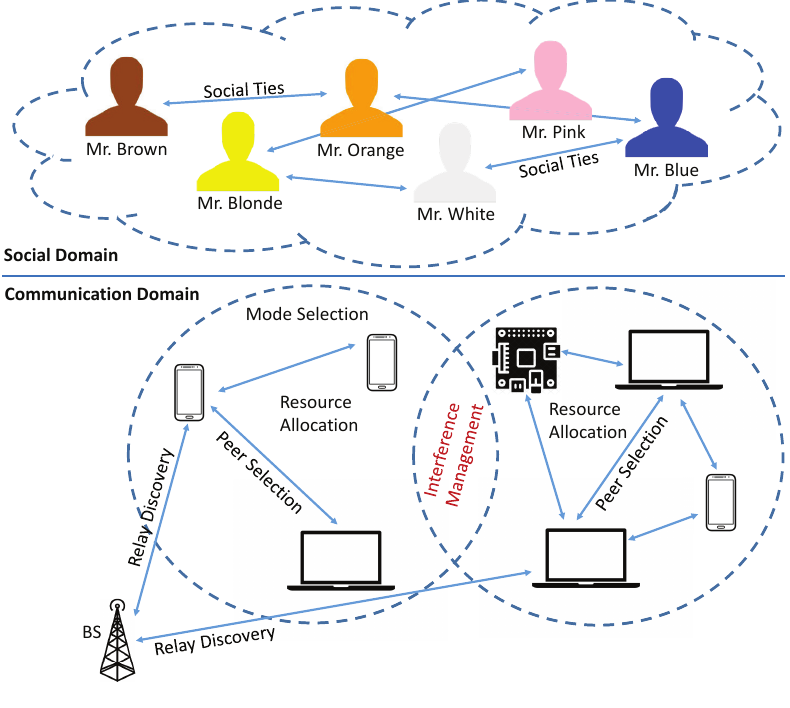
Figure 1. System